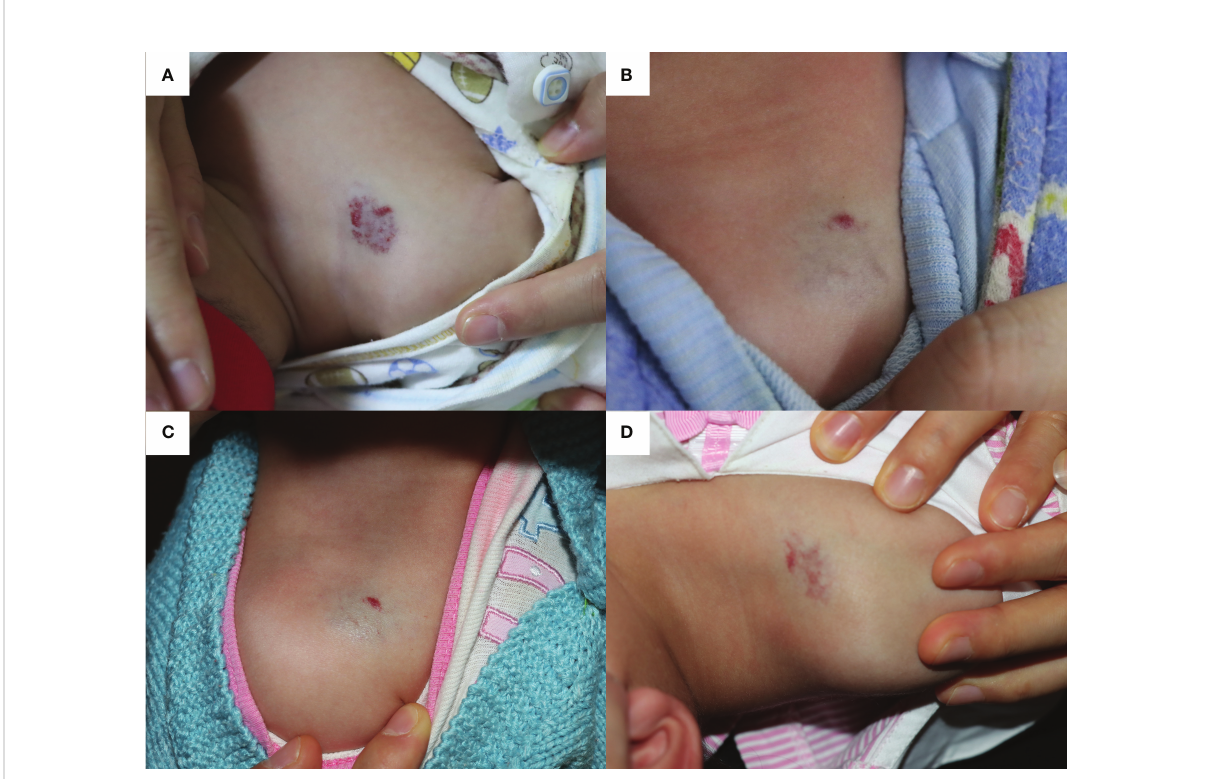
FIGURE 2 The infantile hemangioma in patient 2 at different periods. (A) Proliferating infantile hemangioma before oral propranolol therapy and laser therapy. (B) Involuted infantile hemangioma when the patient was admitted for acute bronchitis at the age of 15 months. (C) Infantile hemangioma showed a proliferation trend after 7 days of nebulized salbutamol treatment. (D) Infantile hemangioma worsened after receiving another 3 days of nebulized salbutamol therapy in the